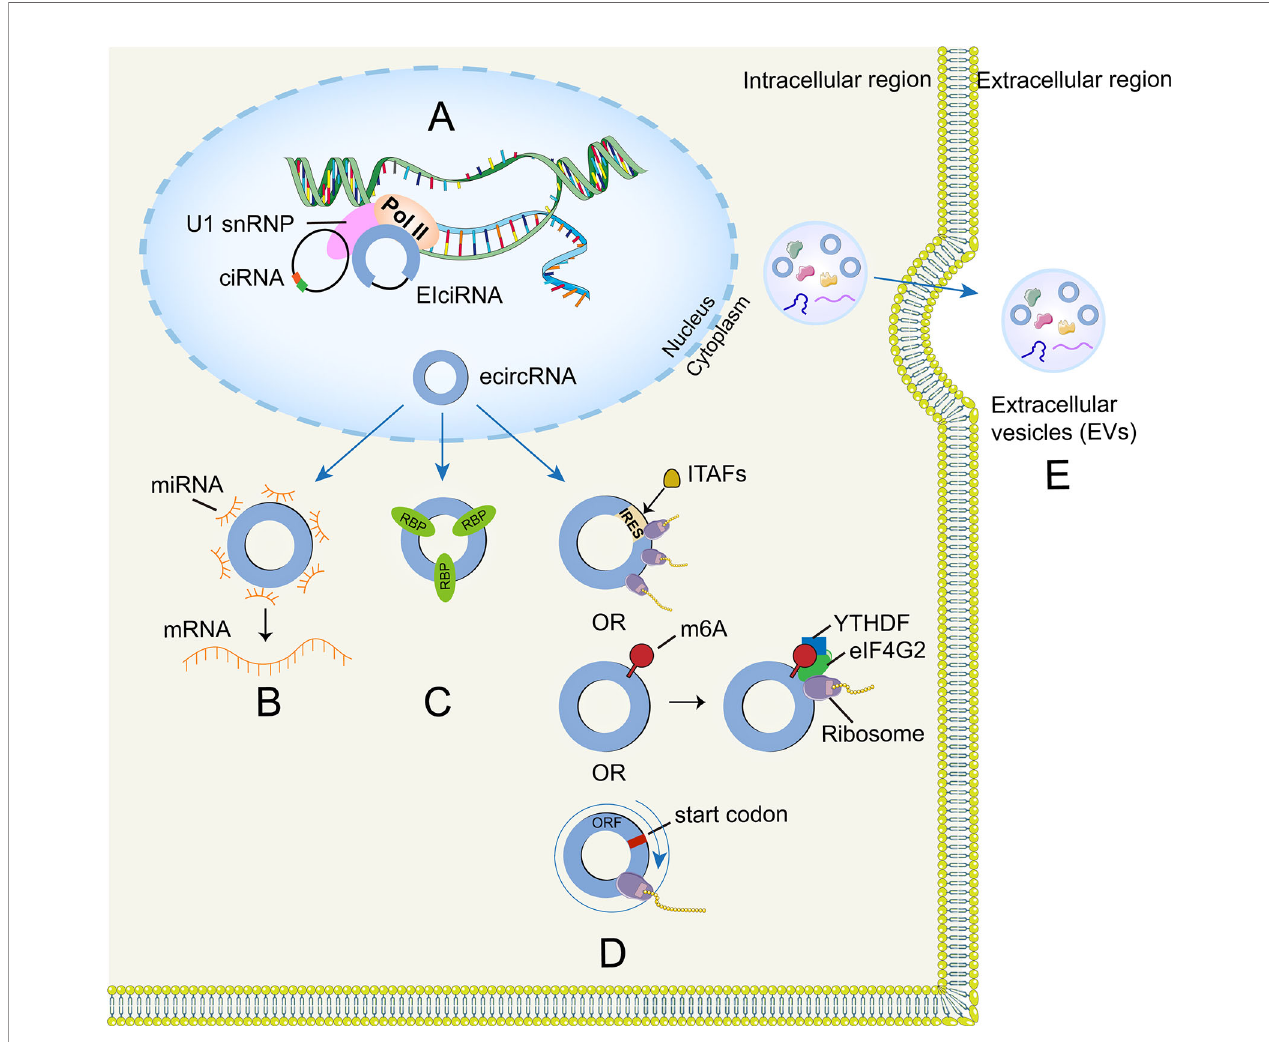
driven mechanisms and rolling circle ampli fi cation mechanism. (E) Exosomal circRNA can be regarded as molecular